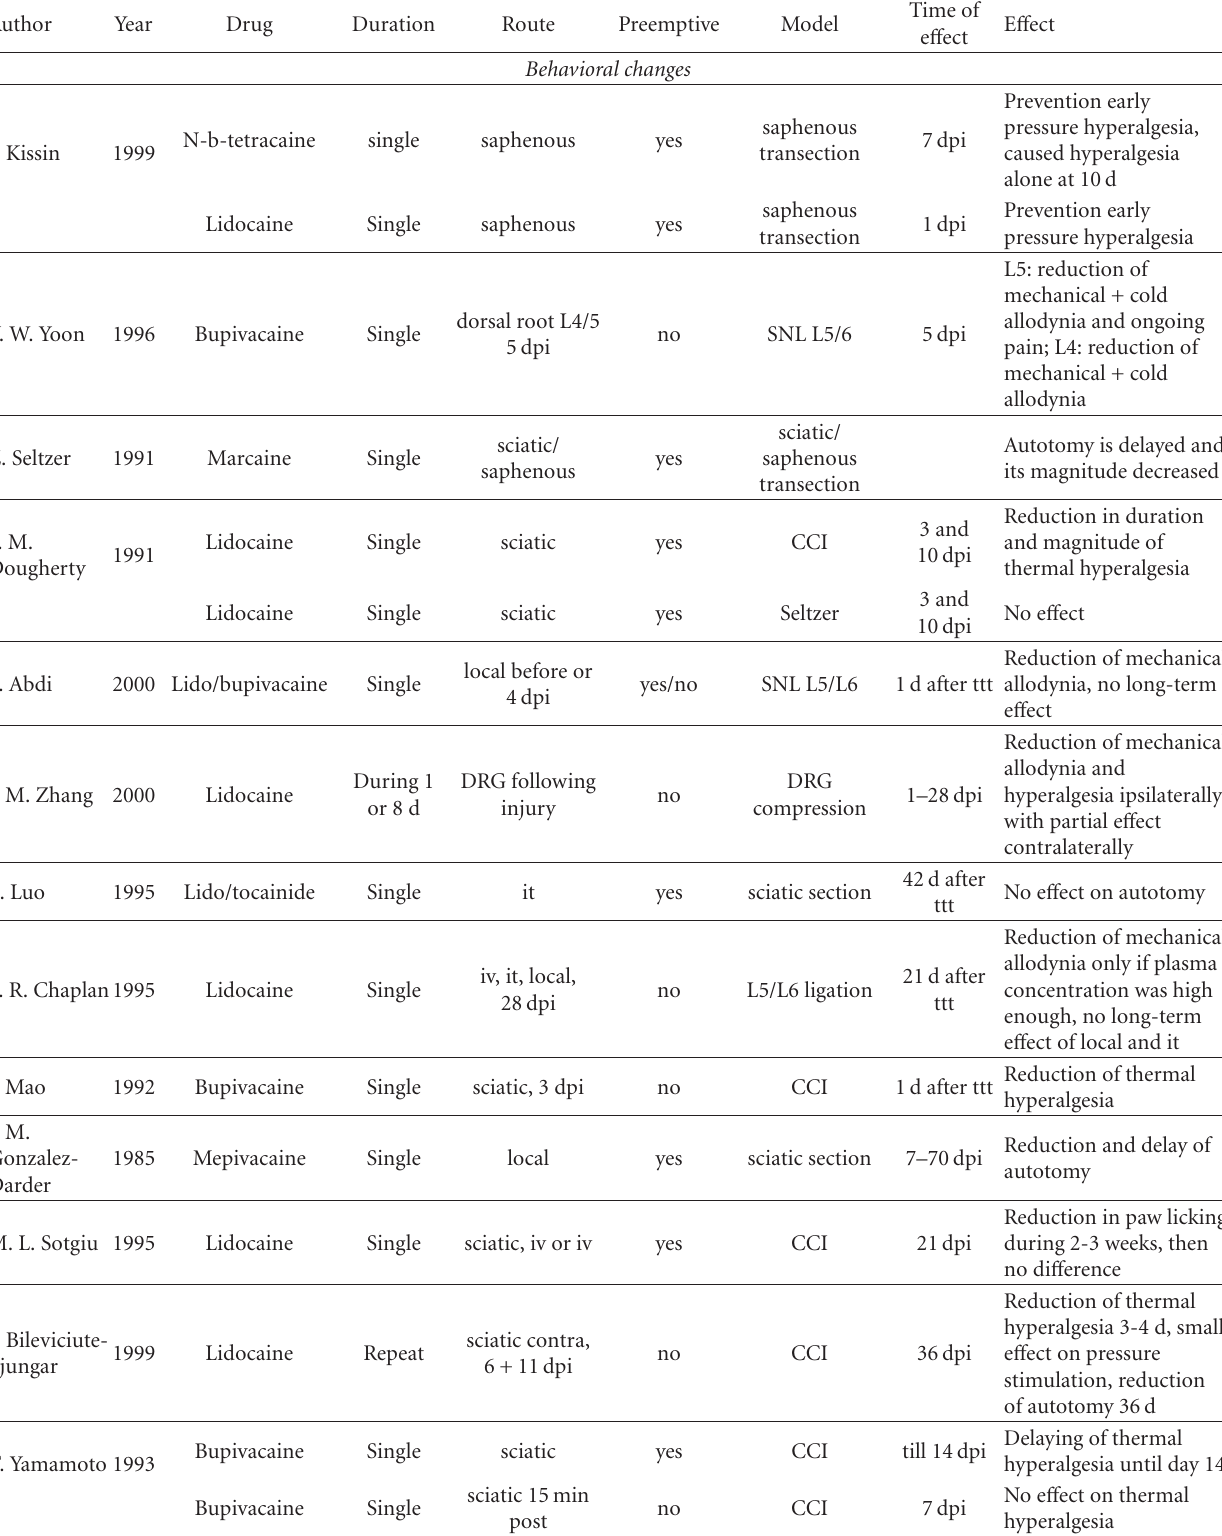
Table 1: E ff ect of block on animal nerve injury models. Single means one application, local means on the injury site, and pre-emptive: yes: before the injury. SNL: spinal nerve ligation, CCI: chronic constriction injury, SNI: spared nerve injury, Seltzer: partial sciatic nerve